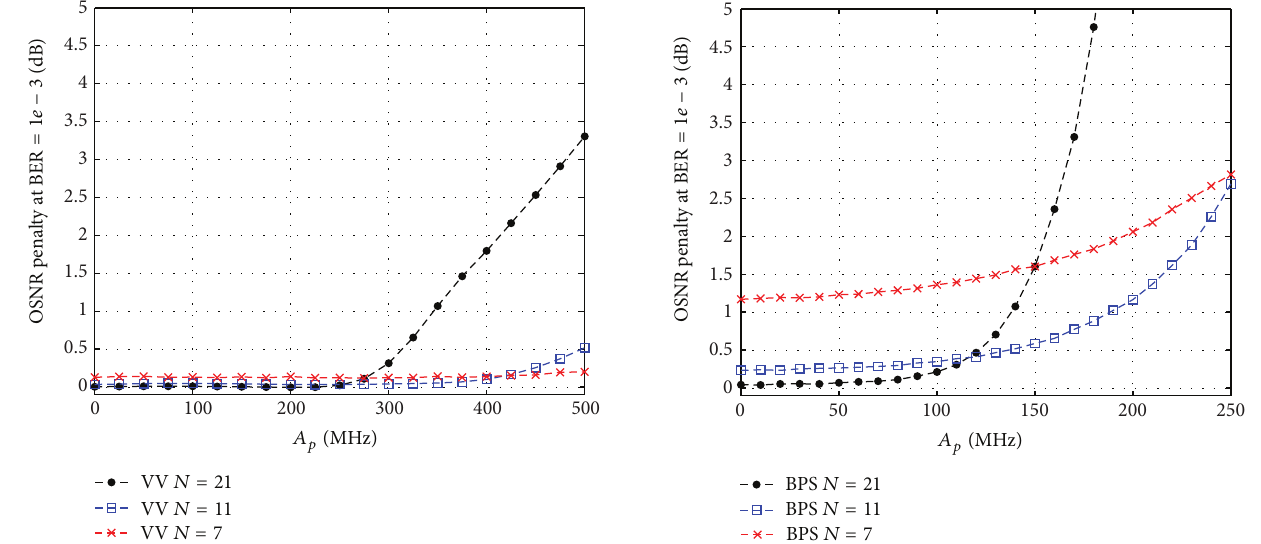
Figure 6: Performance of BPS CPR with 16-QAM versus the freq- uency deviation amplitude ( 𝐴 𝑝 ) for Δ𝑓 𝑐 = 35 KHz, 1/𝑇 = 32 Gs/s, Δ ] = 250 KHz, and 𝐵 = 32 .